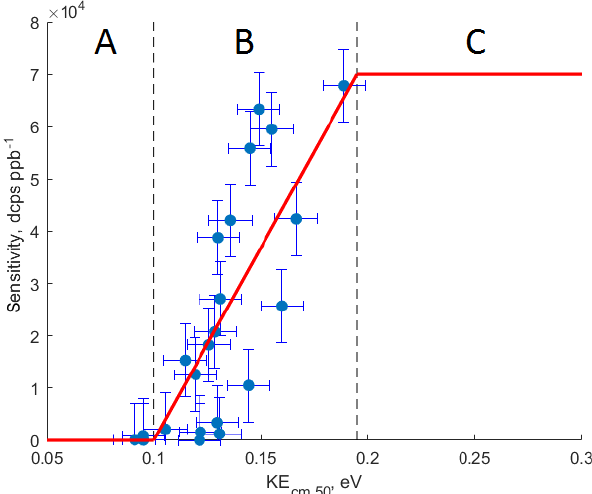
Figure 4. The relationship between calculated kinetic energy of the ammonium–organic clusters KE cm50 and measured sensitivity for calibrated compounds. Molecules characterized by KE cm50 smaller than 0.10eV (region A) cannot be detected by NH + molecules characterized by KE cm50 between 0.10 and 0.19eV (re- gion B) a linear relationship between KE cm50 and measured sensi- tivity is observed; molecules characterized by KE cm50 greater than 0.19eV (region C) are detected at the “kinetic